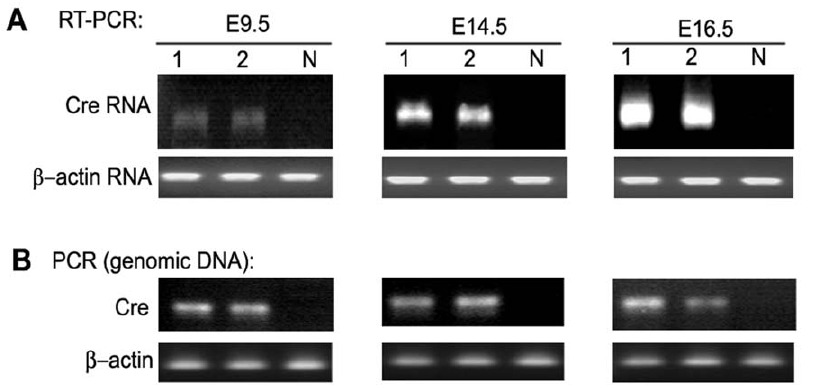
Figure 4. Characterization of Tpbpa r/ Ada f- Ada P- Cre transgene expression at different times during pregnancy. Pregnant mice were sacrificed on days E9.5, E14.5 and E16.5 and placentas were collected. ( A ) RT-PCR was used to analyze the expression levels of Cre and b - actin mRNA in the placentas. Representative expression patterns of Cre and b -actin mRNA in placentas (lane 1 and 2) are shown. N, negative control placenta without transgenic Cre mRNA. ( B ) The presence of the Cre transgene was assessed by PCR analysis of Tpbpa r/ Ada f- Ada P- Cre DNA in placentas of pregnant mice. b -actin DNA was used as an internal control.